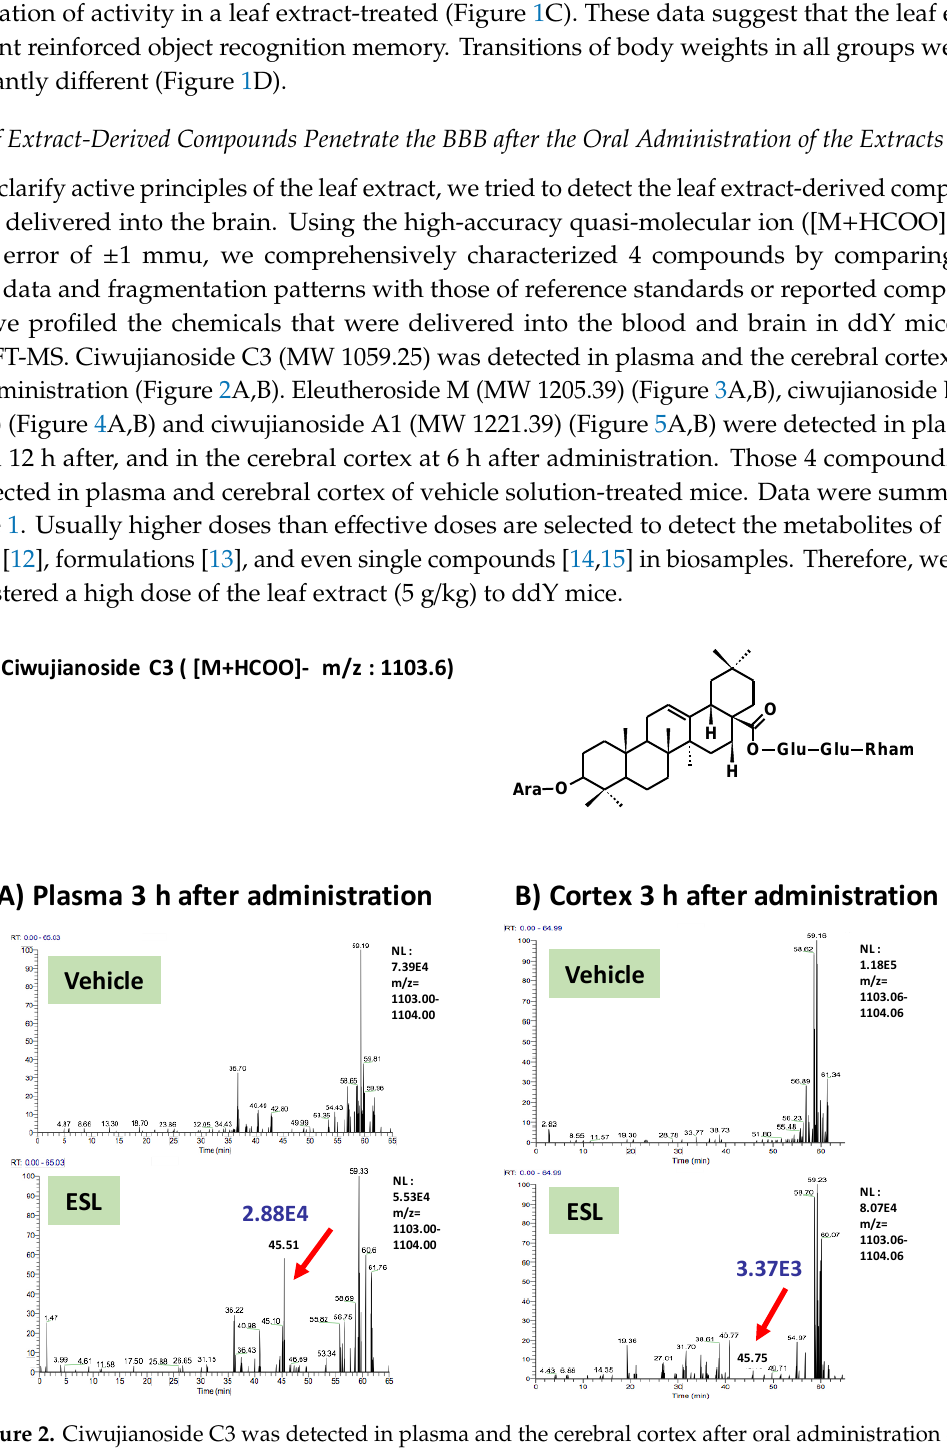
Figure 2. Ciwujianoside C3 was detected in plasma and the cerebral cortex after oral administration of the leaf extract of E. senticosus. A structure of ciwujianoside C3 and LC-MS charts of plasma ( A ) and cerebral cortex ( B ) from vehicle-treated and leaf extract-treated mice 3 h administration of the extract. Red arrows indicate a peak of ciwujianoside C3. A blue value means intensities of the peak.